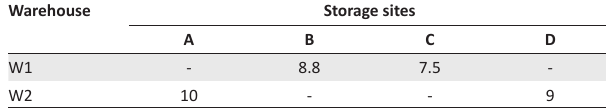
TABLE 3: Distance between warehouse and storage sites (km). Warehouse